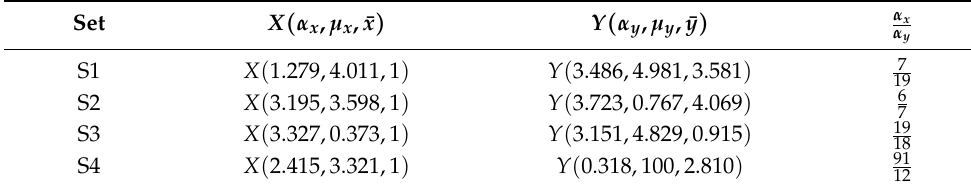
Table 1. Random variables considered for numerical analyses.